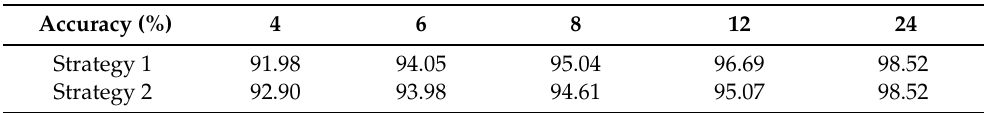
Table 6. The average recognition accuracy for different training position selection strategies and different numbers of training